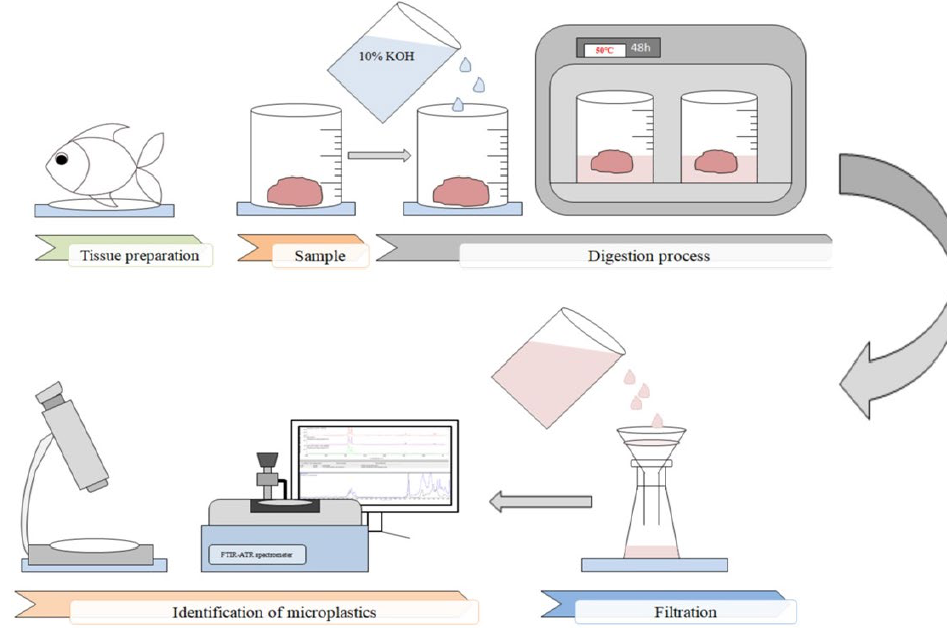
Figure 2. Schematic diagram of microplastic extraction and the identification protocol.